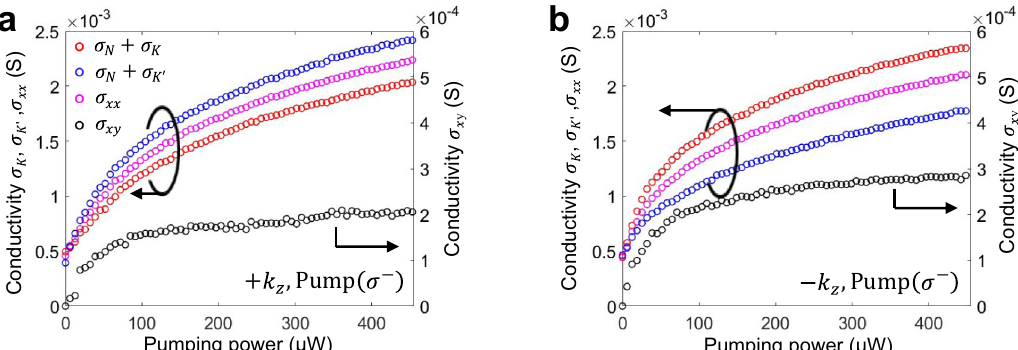
Fig. 3 Measured dichroic surface conductivity of WS 2 under CP optical pump. a , b Surface conductivities obtained from experimental data by the fi tting re fl ectance for both + k z and − k z directions of the CP probes. Diagonal element of the surface conductivity plotted alongside with the off-diagonal element. The dots in a , b show values extracted from experimentally measured re fl ectivities. (Supplementary